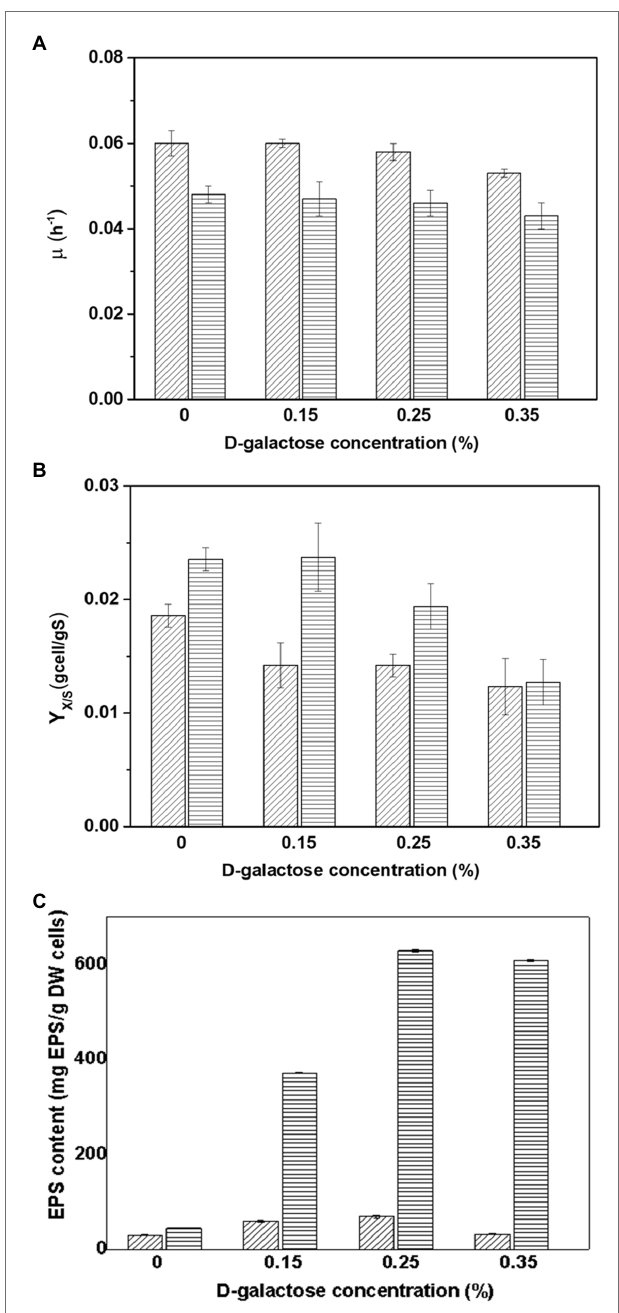
FIGURE 1 | Parameters obtained in the cultures of Acidithiobacillus thiooxidans DSM 14887 T (diagonal lines) and Leptospirillum ferrooxidans DSM 2705 T (horizontal lines) adapted to different concentrations of D-galactose. (A) Maximum specific growth rate ( μ max ). (B) Yield of biomass (Y X/S ). (C) EPS content (mg of EPS by g of DW cells). The data correspond to the mean values of triplicates ± SD ( n =